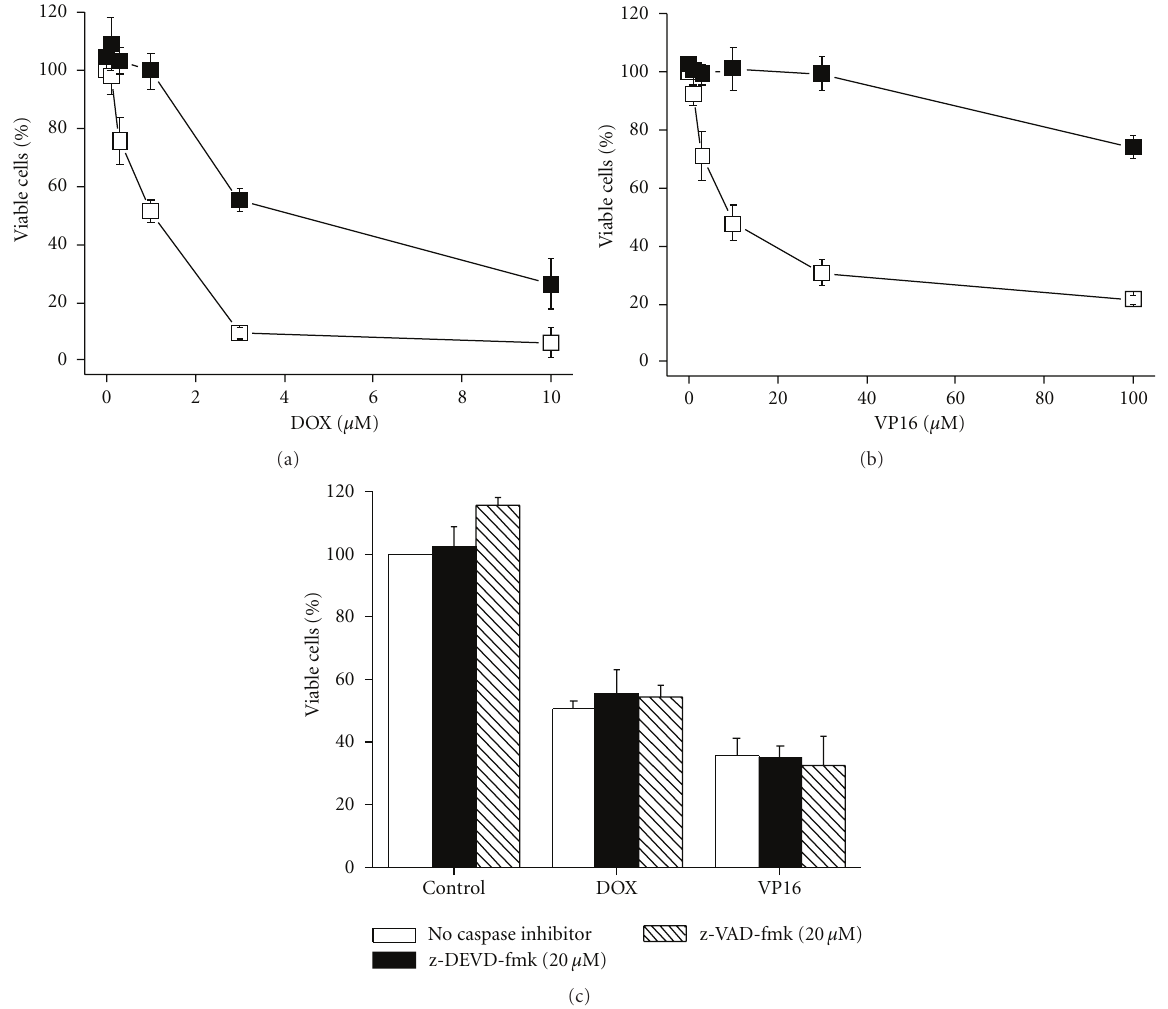
Figure 8: Long-term IGF1 treatment induces resistance to conventional chemotherapeutic agents. Percentage of viable VH-64 cells incubated for 72 hours in the absence ( (cid:2) ) and presence ( (cid:3) ) of IGF1 (100ng/mL), followed by incubation for 18 hours with the indicated concentrations of (a) DOX and (b) VP16. (c) Percentage of viable VH-64 cells incubated for 30 min in the absence and presence of 20 μ M z-DEVD-fmk and 20 μ M z-VAD-fmk, followed by incubation for 18 hours with DOX (1.5 μ M), VP16 (20 μ M), and serum-free medium alone (Control). Error bars: mean ± SD of triplicate determinations from 4 independent